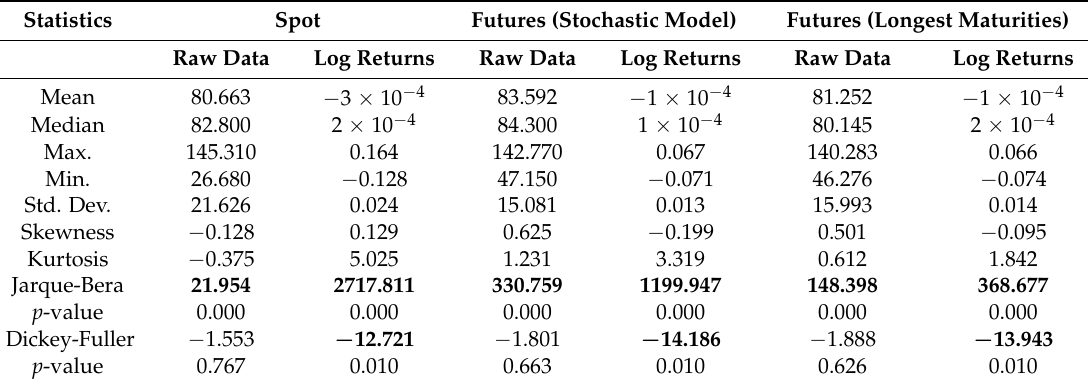
Figure 3. WTI spot and futures prices (obtained as the longest maturities and estimated by a stochastic model) covering the time interval from 24 February 2006 to 2 April 2016 and where each time series contain 2571 elements. Source: own work with spot price data from US Energy Information Administration (EIA) and Last Futures Price from Intercontinental Exchange (ICE). Table 3. Descriptive statistics for spot and long-term futures prices.